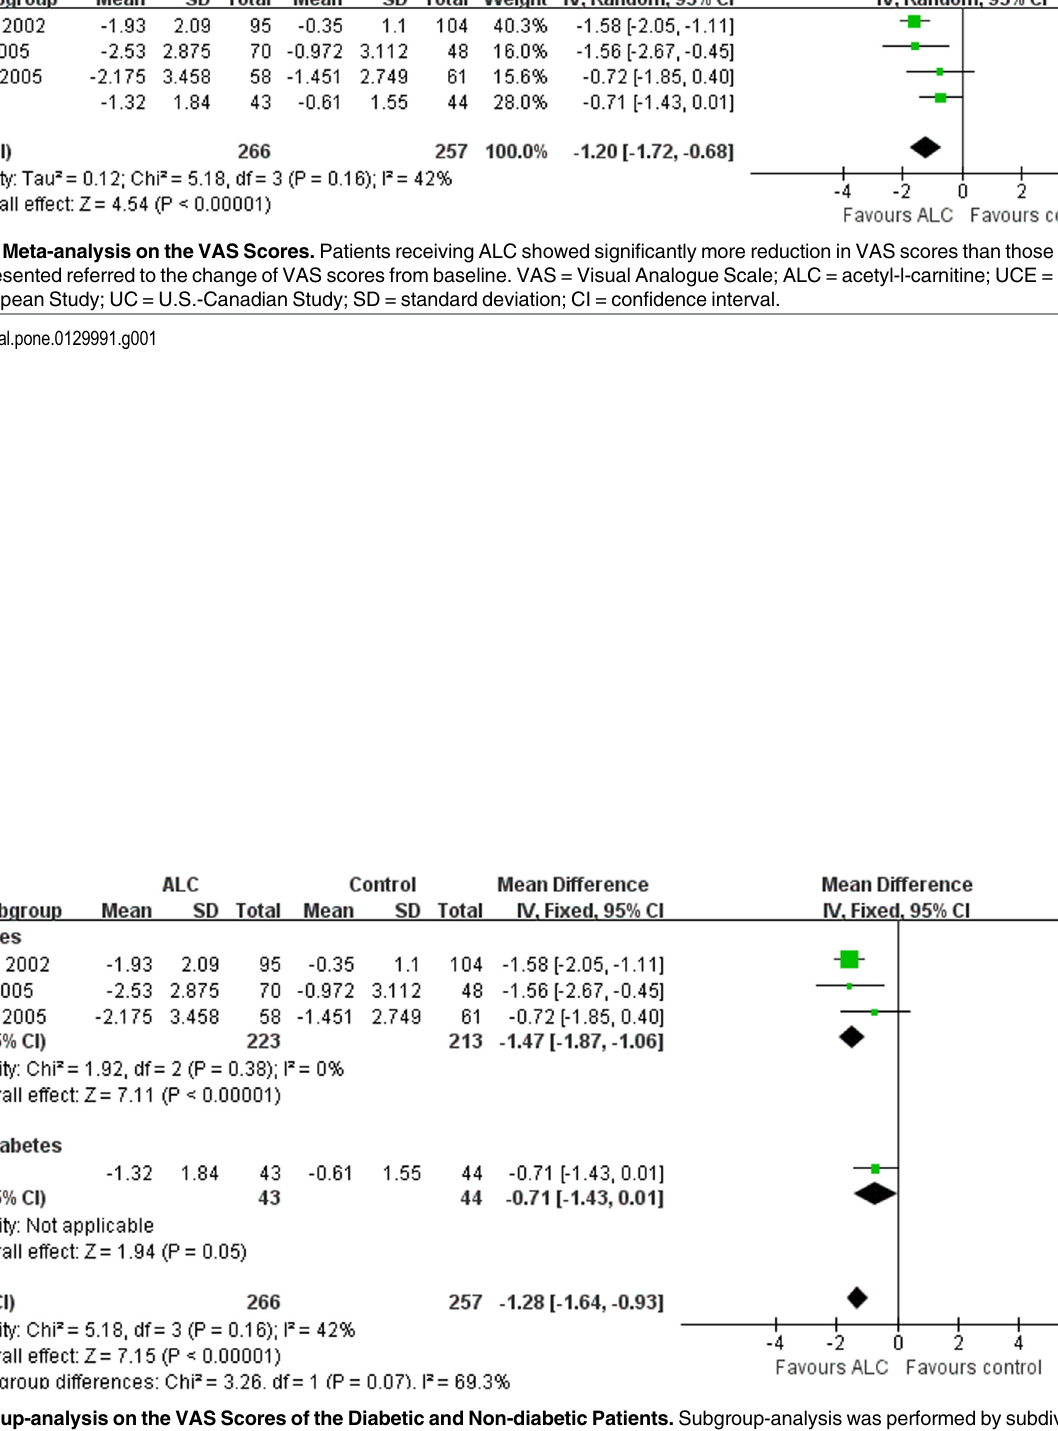
Fig 3. Subgroup-analysis on the VAS Scores of the Diabetic and Non-diabetic Patients. Subgroup-analysis was performed by subdividing RCTs according to whether the peripheral neuropathy diagnosed in patients was diabetic or non-diabetic. Taking ALC decreased VAS scores significantly in diabetic patients. VAS = Visual Analogue Scale; ALC = acetyl-l-carnitine; UCE = U.S.-Canadian-European Study; UC = U.S.-Canadian Study; SD = standard deviation; CI = confidence interval.